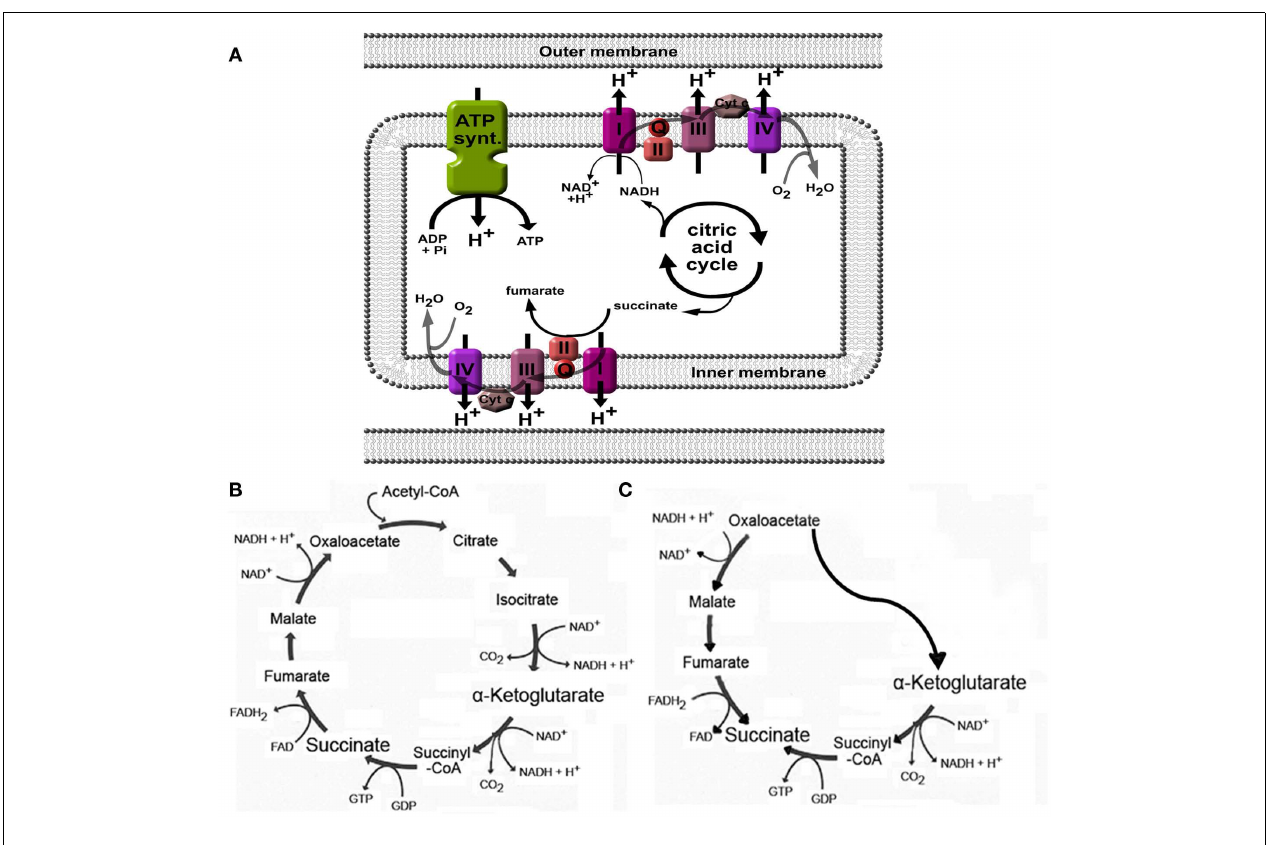
accumulation of succinate. (B) Overview of the citric acid cycle under normal physiological conditions. (C) Cellular stress such as hypoxia may affect normal functioning of the citric acid cycle and induce a part of the cycle to run in reverse, ultimately leading to increased succinate production. See text for more details and